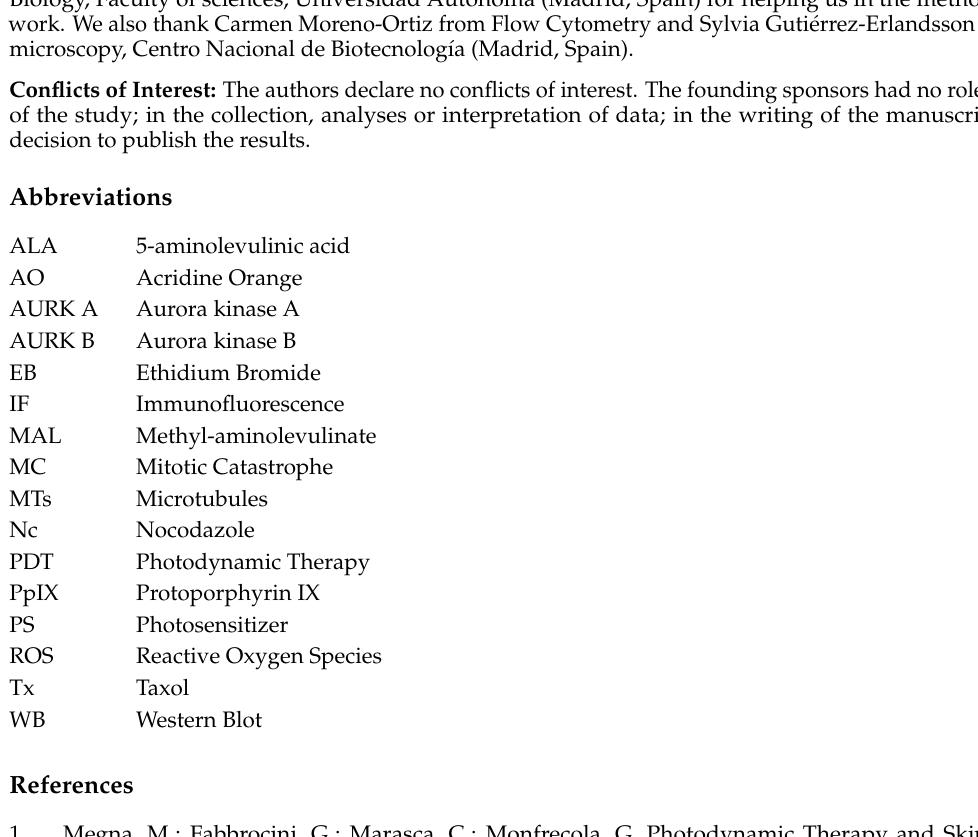
and AURKB cell cycle phases of control HeLa cells; Figure S5: justification methodology. Movie 1: control cells; Movie 2: MAL-PDT